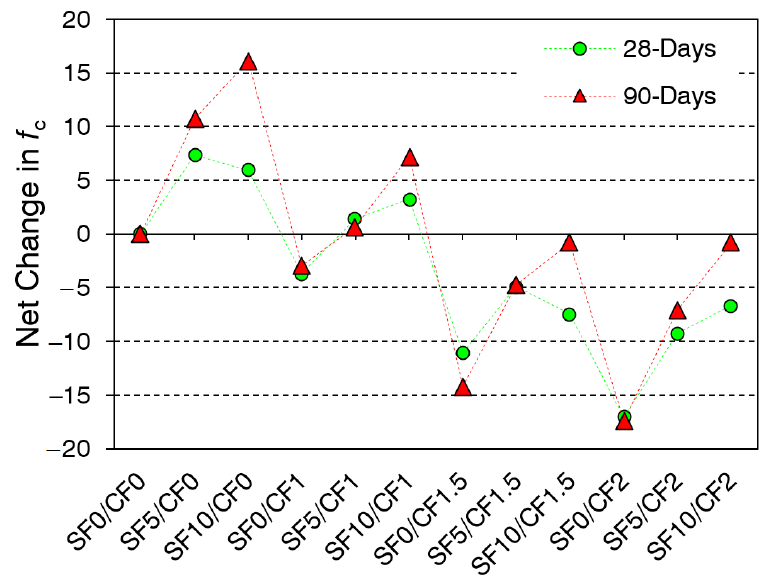
Figure 8. Net change in compressive strength due to silica fume and coir addition.